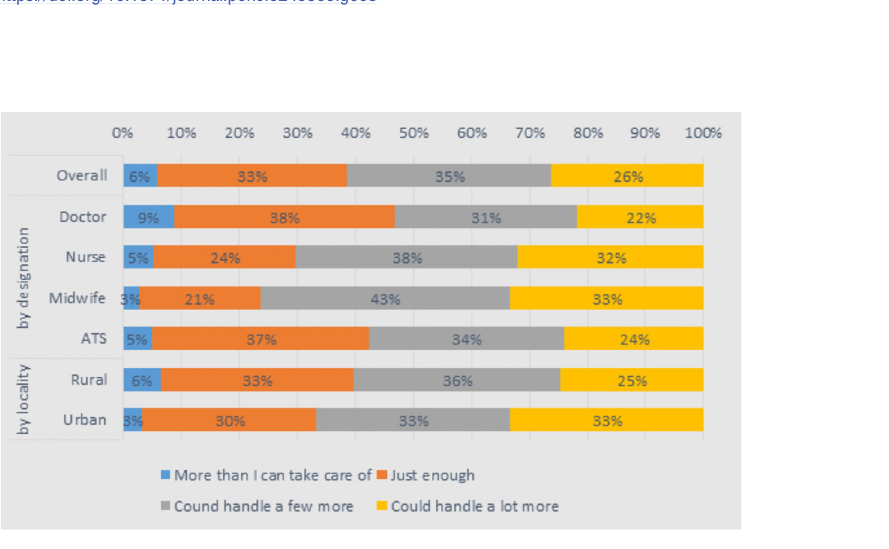
Fig 4. How do you feel about the number of patients you are seeing in a